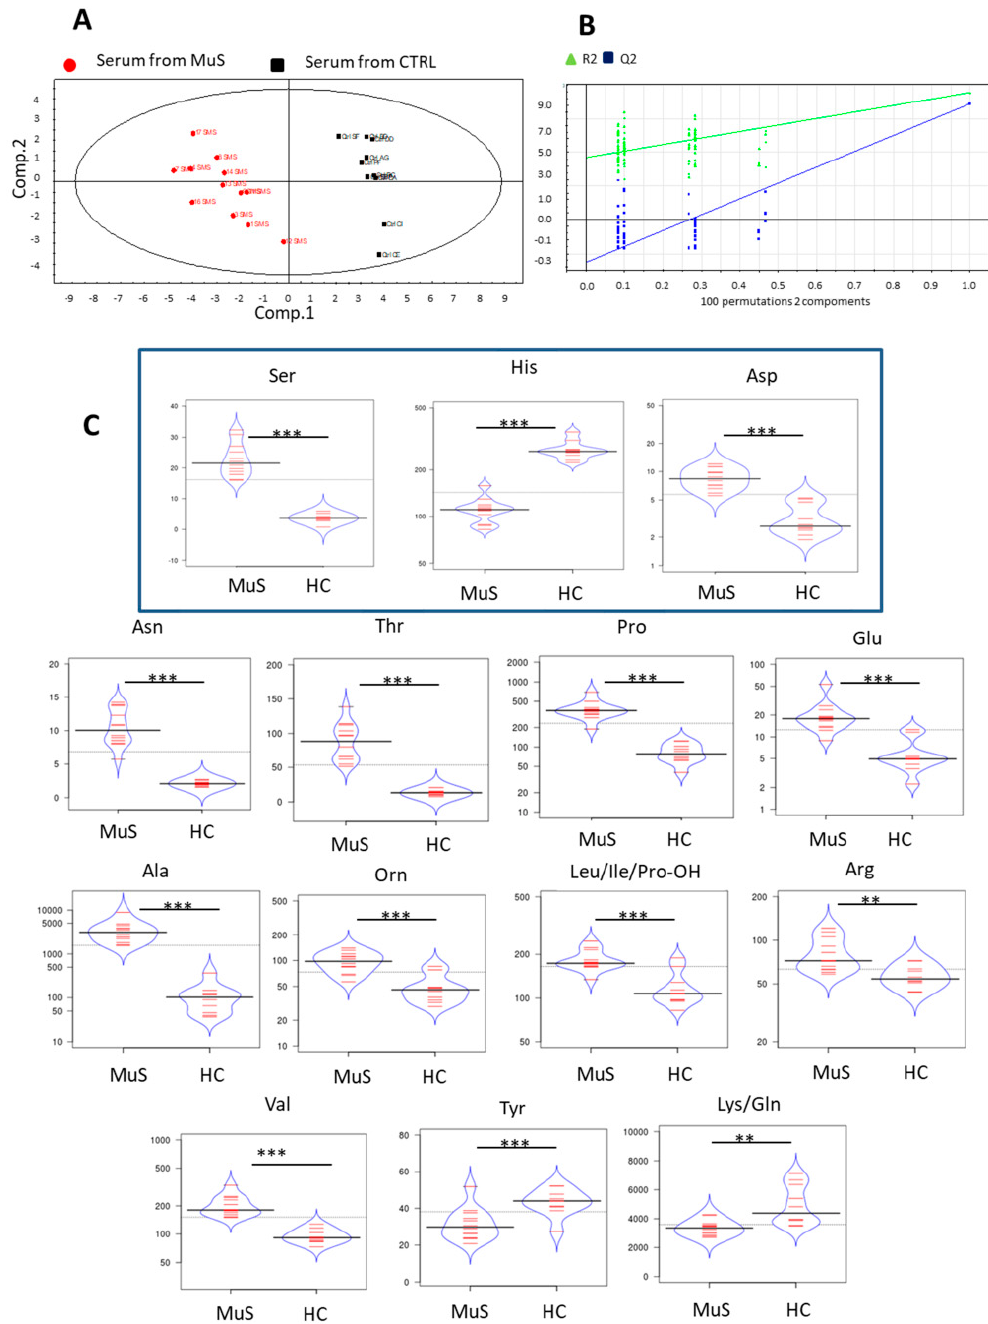
Figure 5. Serum metabolomics investigation by PLS-DA ( A ) Panel shows the Scores scatter plot calculated on two components. The (PLS-DA) are used to classify sera from MuS patients (symbolized as red dots) from HCs (indicated as black squares) obtained by R2Y = 0.94 and Q2(cum) = 0.861. ( B ) In Panel we report the validate model plots for serum model of PLS-DA. ( C ) The bean plots in Panel show the distribution of the serum significantly different AAs in the two analyzed groups. * means p < 0.05, ** means p < 0.01 and *** means p < 0.001 at the Student’s t-test.